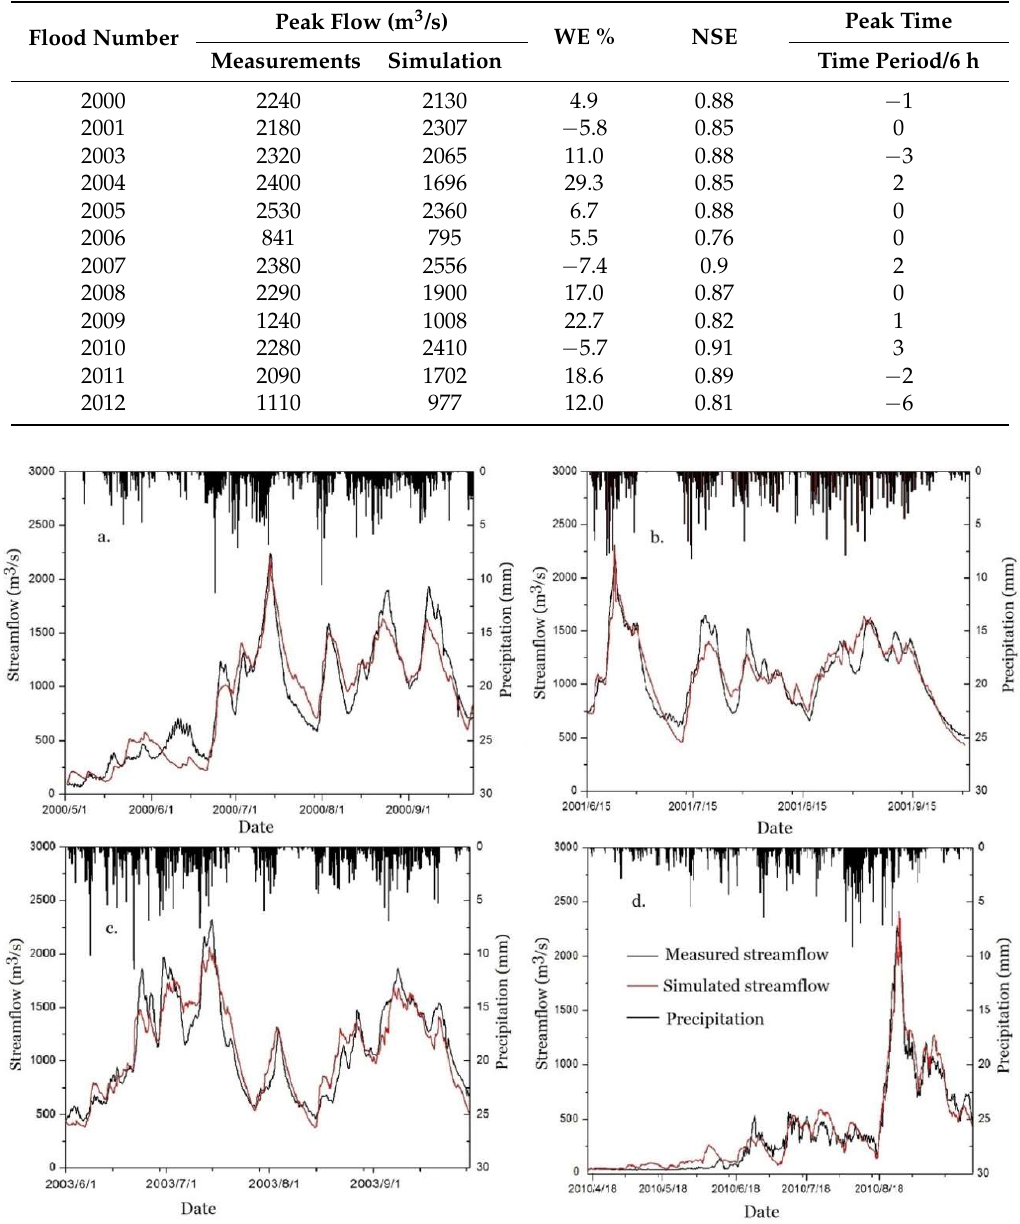
Table 6. Comparisons between the measurements and simulation on flood events from 2000 to 2012. Flood Number